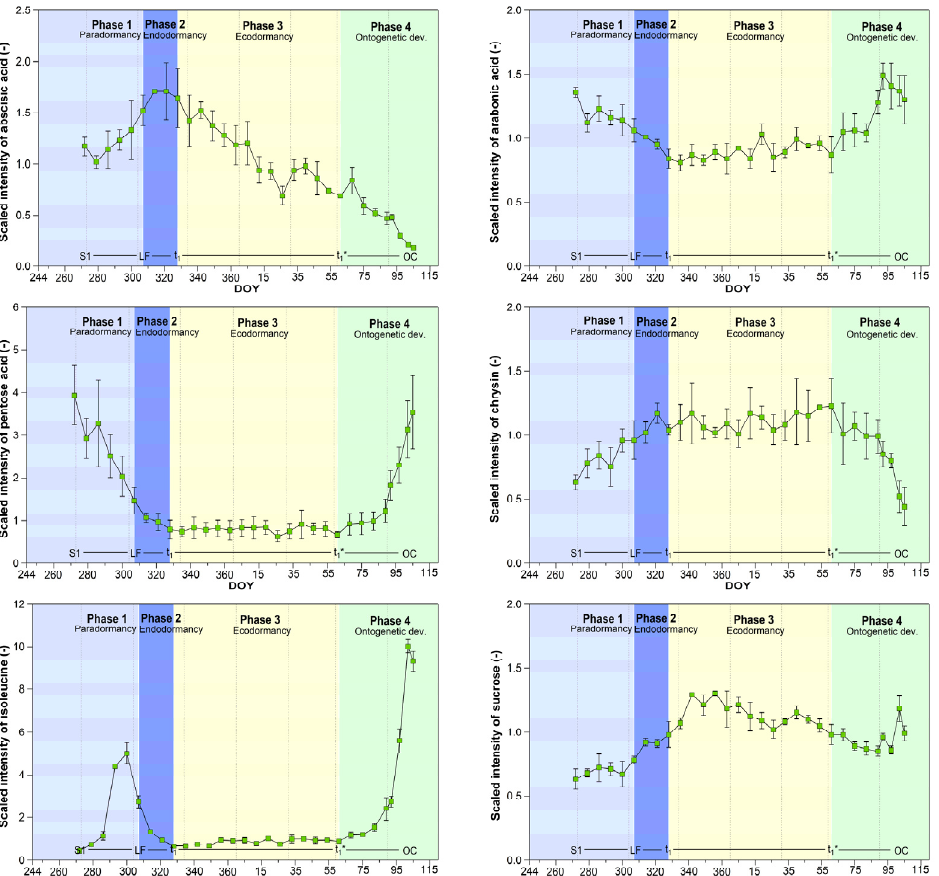
Figure 5. Pattern of mean intensity of abscisic acid, arabonic acid, pentose acid, chrysin, isoleucine and sucrose in the season 2015/16. Phase 1: end of paradormancy (first sampling S1-‘total leaf fall’ LF), phase 2: endodormancy (LF-endodormancy release t 1 ), phase 3: ecodormancy (t 1 -beginning of ontogenetic development t 1 *), phase 4: first stage of ontogenetic development (t 1 *-‘open cluster’ OC). Error bars show the standard deviation ( n = 3), DOY, day of year.